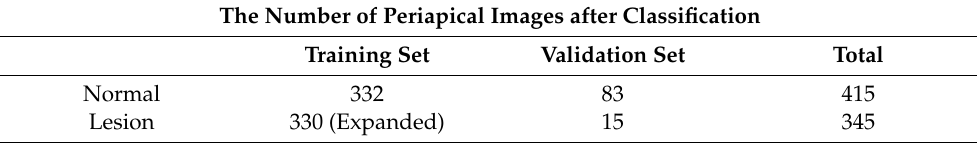
Table 1. Data Classification of the periapical image after